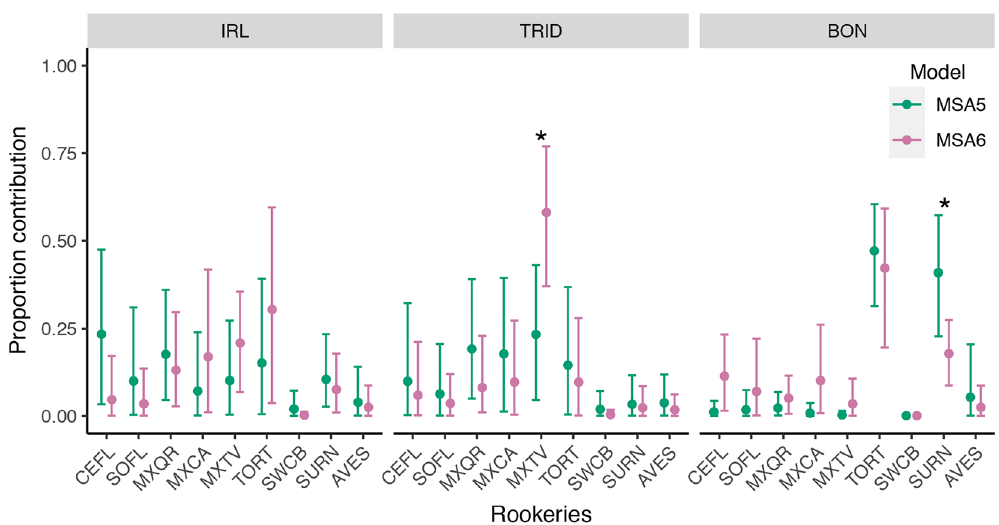
Figure 4. Mixed stock-centric estimates with different sampling events and varying source sizes. Circles represent the mean estimate, and vertical bars 95% credible intervals. MSA 5 “old” mixed stock sampling period and “historical” source size. MSA 6 “new” mixed stock sampling period and “recent” source size. Asterisk: rookeries with evidence of a difference in contribution in response to source size variation. See Fig. 1 for site